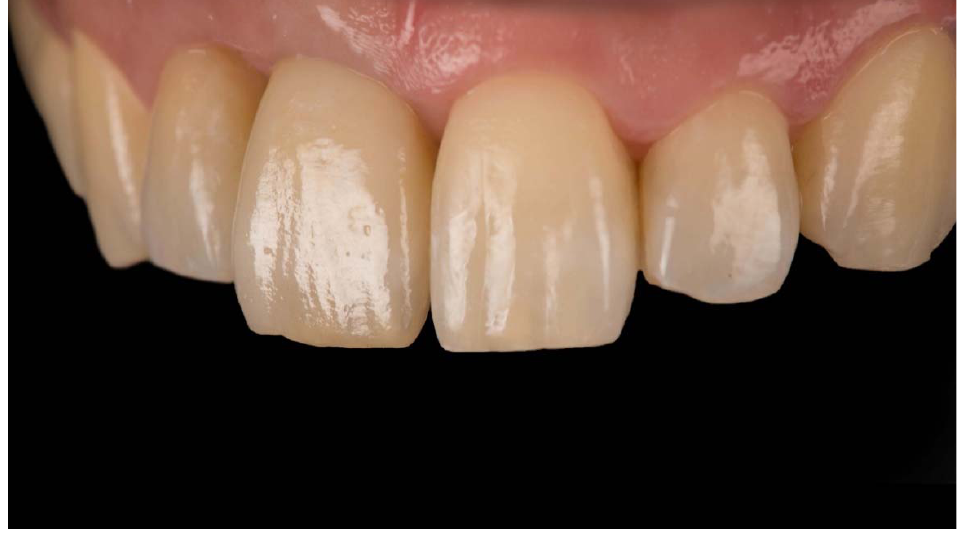
Figure 8. Implant ‐ supported restoration in place. Figure 8. Implant-supported restoration in